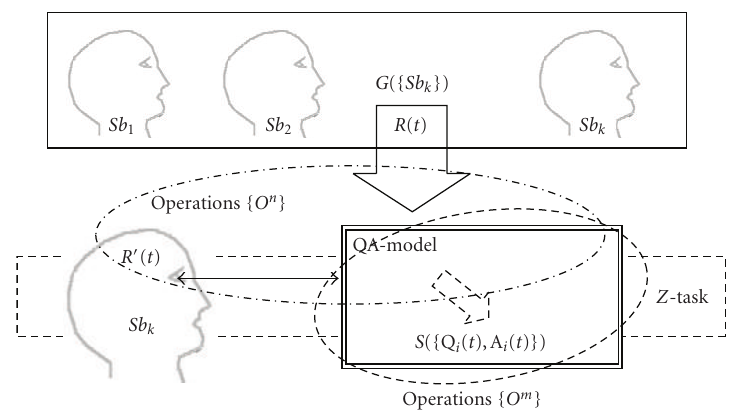
Figure 2: Scheme of question-answer base for